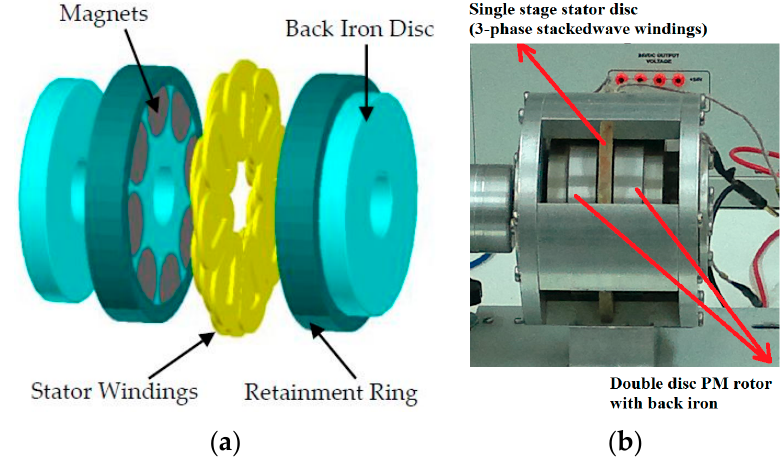
Figure 1. AFPMA under consideration: ( a ) 3D exploded view of ACSTR; ( b ) assembled AFPMA.